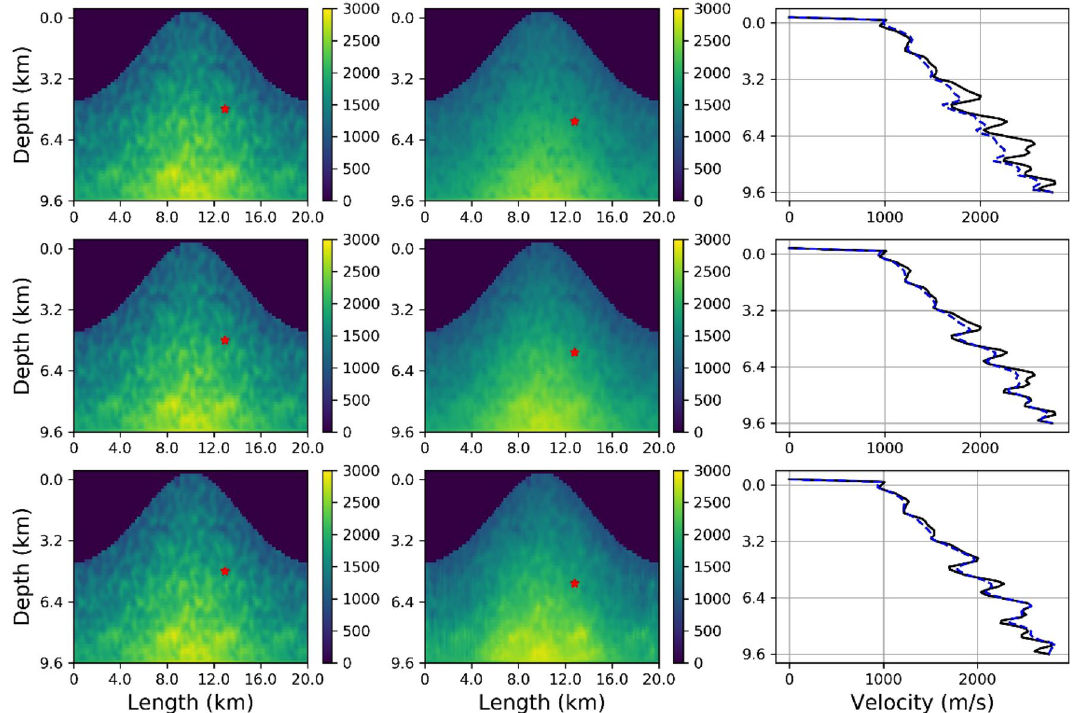
Figure 8. Top panels show from left to right, the true velocity model taken from population V, the FNO inversion result using synthetic seismograms from one shot gather (one source and associated seismograms), and a comparison of the velocity profiles. The FNO network was trained using seismic data simulated in velocity models drawn from population T. The middle panels replicates the top panels except the FNO result is the sum of 20 different inversions for different sources in different locations, using the same model, i.e. stacking velocity models FNO predicted from 20 shot gathers with randomly located sources. The bottom panels show results after stacking 100 predicted velocity models. The right hand panels clearly show the convergence to an accurate velocity model after stacking multiple velocity model predictions derived from different shot gather FNO inputs, with the true model shown by the solid line and the prediction by the dashed